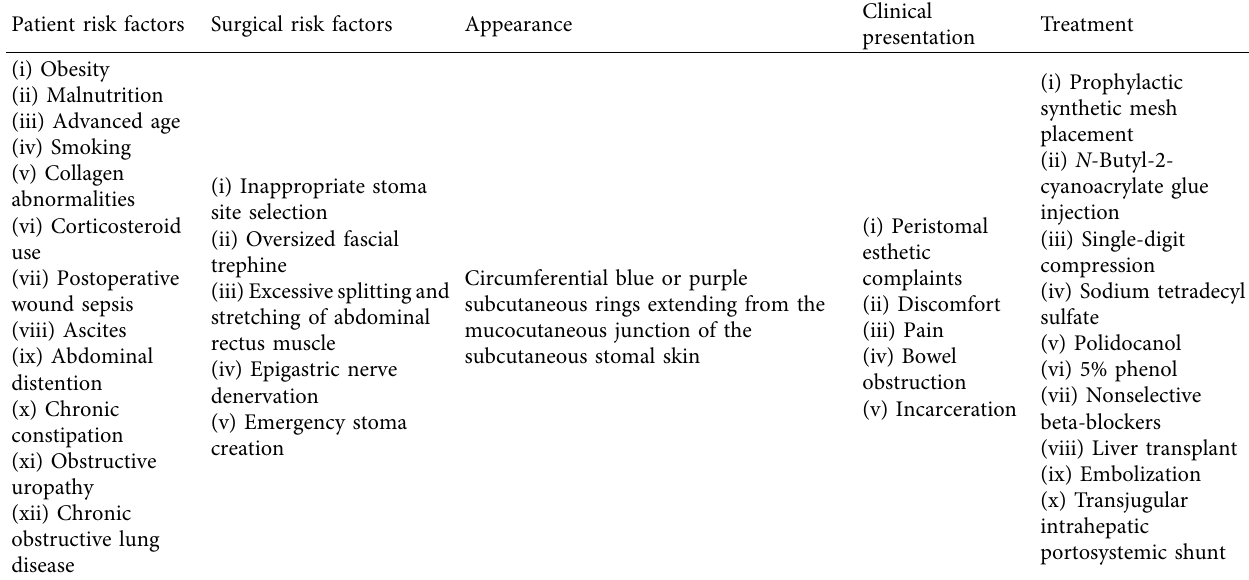
Figure 1: (a–c) Abdominal CT scans demonstrating dilated parastomal varices (red arrows). (d) Image depicting parastomal varices and Table 1: Summary of parastomal varices risk factors, presentation, and treatment [4–6].